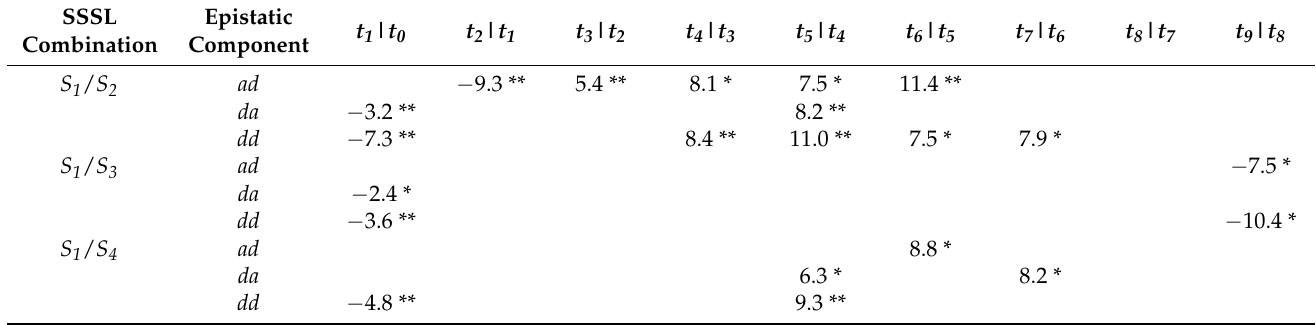
Table 5. Expression of QTLs according to the epistatic effects on the leaf number in various devel- opmental stages. SSSL is an abbreviation of single-segment substitution line. S i / S j represents the combination of SSSL i and SSSL j . aa , ad , da , and dd represent additive-additive, additive-dominant, dominant-additive, and dominant-dominant epistases, respectively. t i | t i − 1 indicates the stage from i − 1 to t . “ − ” indicates descending leaf numbers due to alleles from the donors. * and ** show significance at the levels of the 0.05 and 0.01 probabilities,